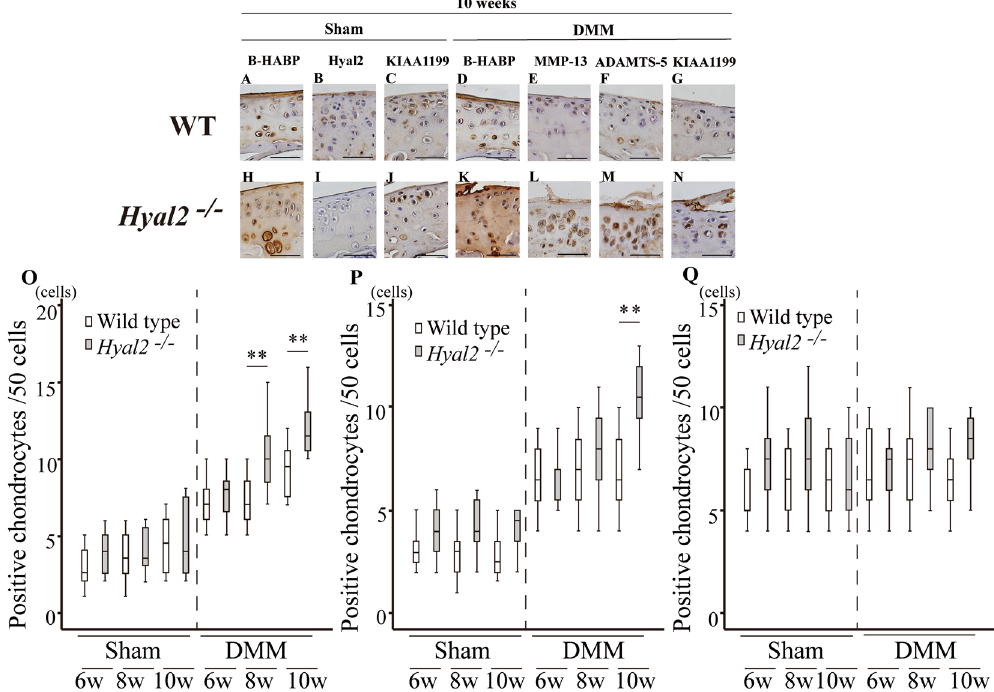
Figure 6. Results of b-HABP and immunohistochemical staining. Staining of articular cartilage in medial tibia at 10 weeks after surgery. B-HABP staining of sham operated side (A; WT, H; Hyal2 − / − ) and DMM operated side (D; WT, K; Hyal2 − / − ). Hyal2 (B; WT sham, I; Hyal2 − / − sham), MMP-13 (E; WT DMM, L; Hyal2 − / − DMM), ADAMTS-5 (F; WT DMM, M; Hyal2 − / − DMM), and KIAA1199 (C; WT sham, J; Hyal2 − / − sham, G; WT